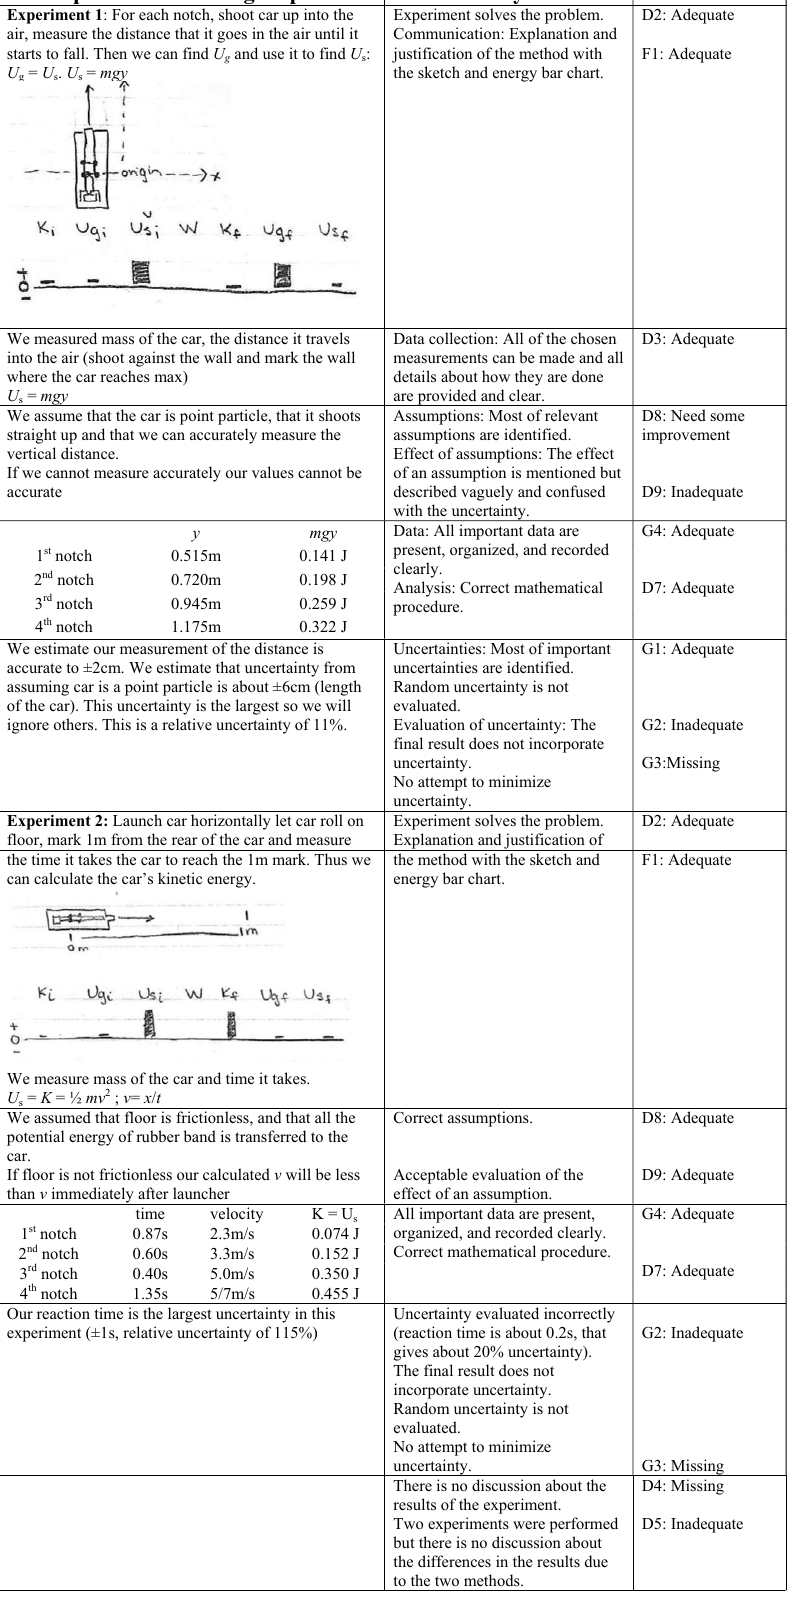
E xperiment solves the problem. Communication: E xplanation and justification of the method with the sketch and energy bar